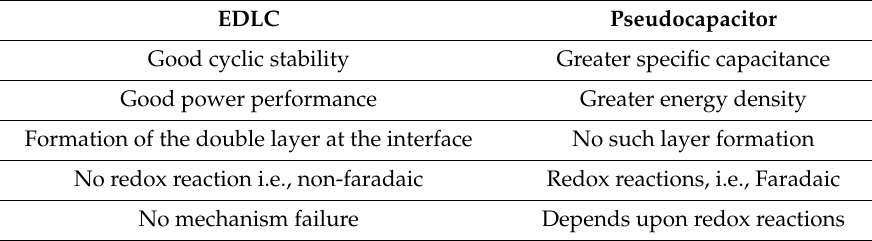
Table 1. Comparison between electric double layer capacitors and